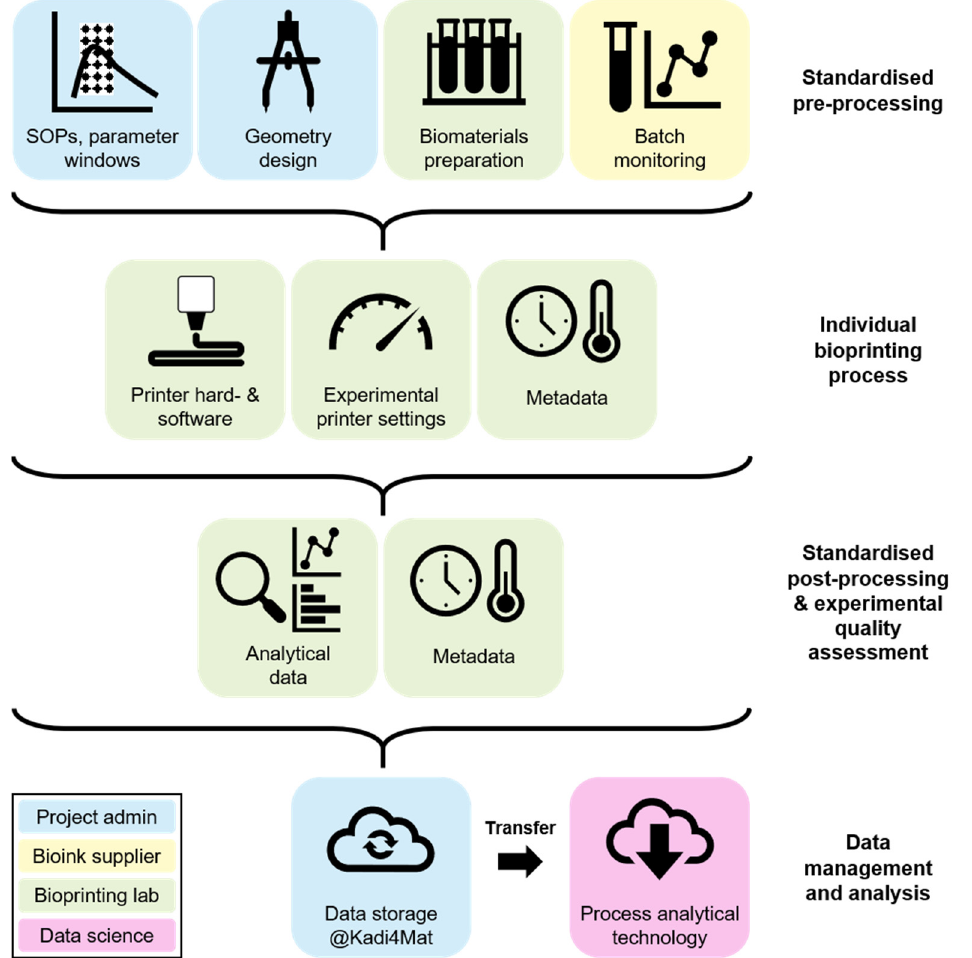
Figure 1. Schematic workflow of a bioprinting experiment and its connected data. The bioprinting process can be separated in pre-processing phase, the actual 3D printing procedure and post-processing [4], which includes the preparation for the application of the 3D printed object (in a biological experiment) and the analysis of the printing outcome. Data of a variety of file formats are collected describing the equipment, consumables and the execution of the process step, including metadata on the ambient conditions and deviations from the SOPs. The colour code illustrates that data are generated by all participants.